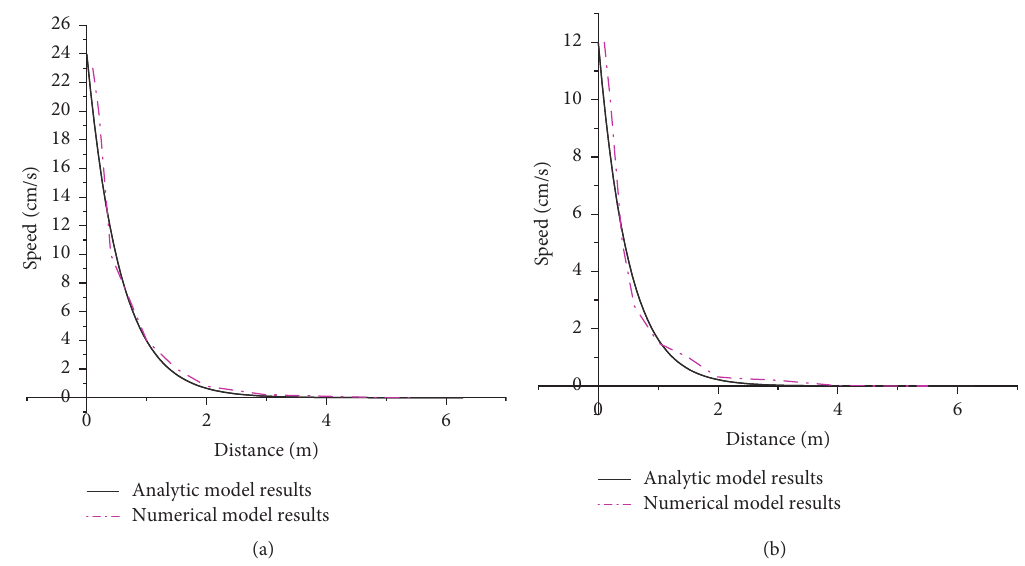
Figure 12: Comparison of velocity field caused by blasting load and numerical results. (a) Variation of radial speed with axial distance. (b) Variation of axial speed with axial distance.